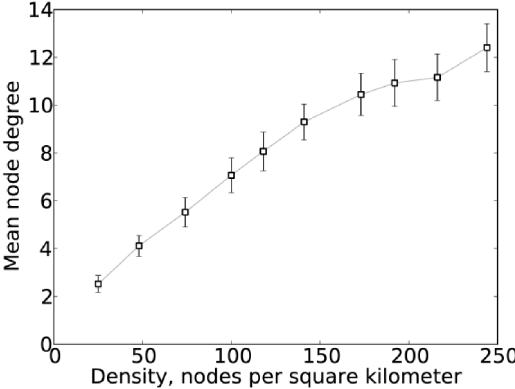
Figure 2. Mean node degree versus density of nodes in simulated